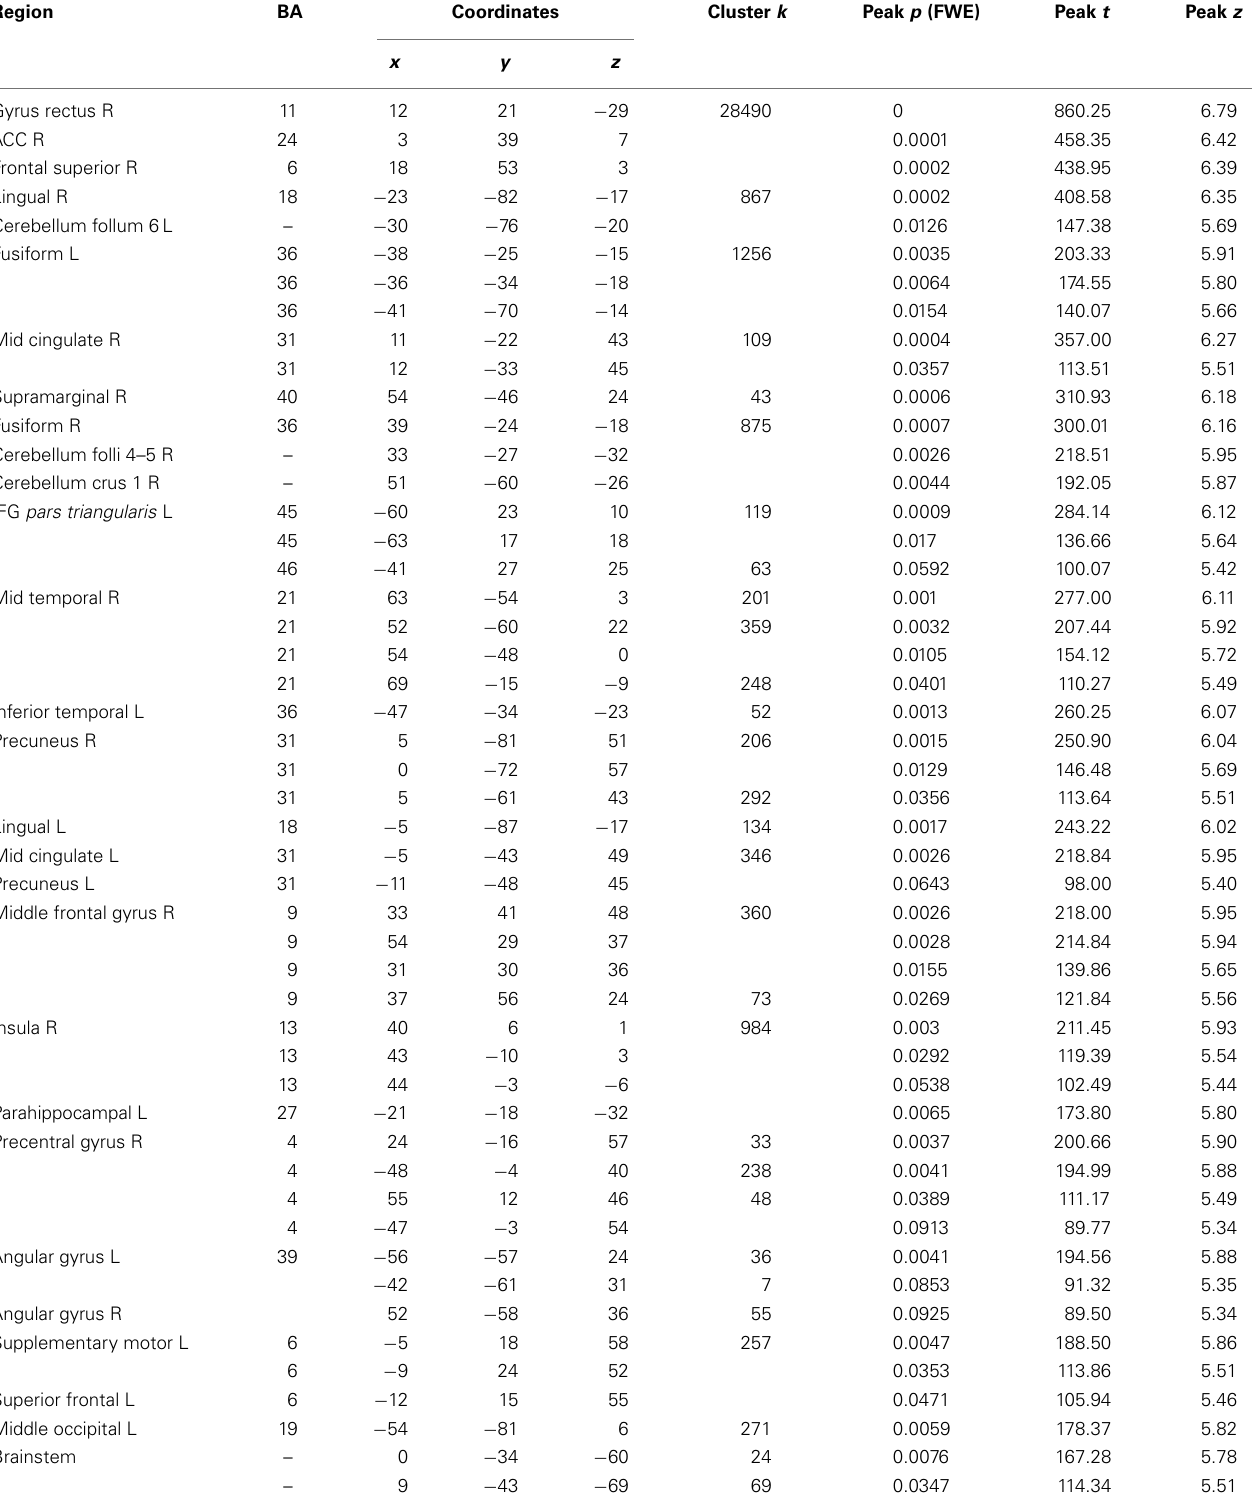
Table 4 | Brain sites of spared gray matter volume in CS